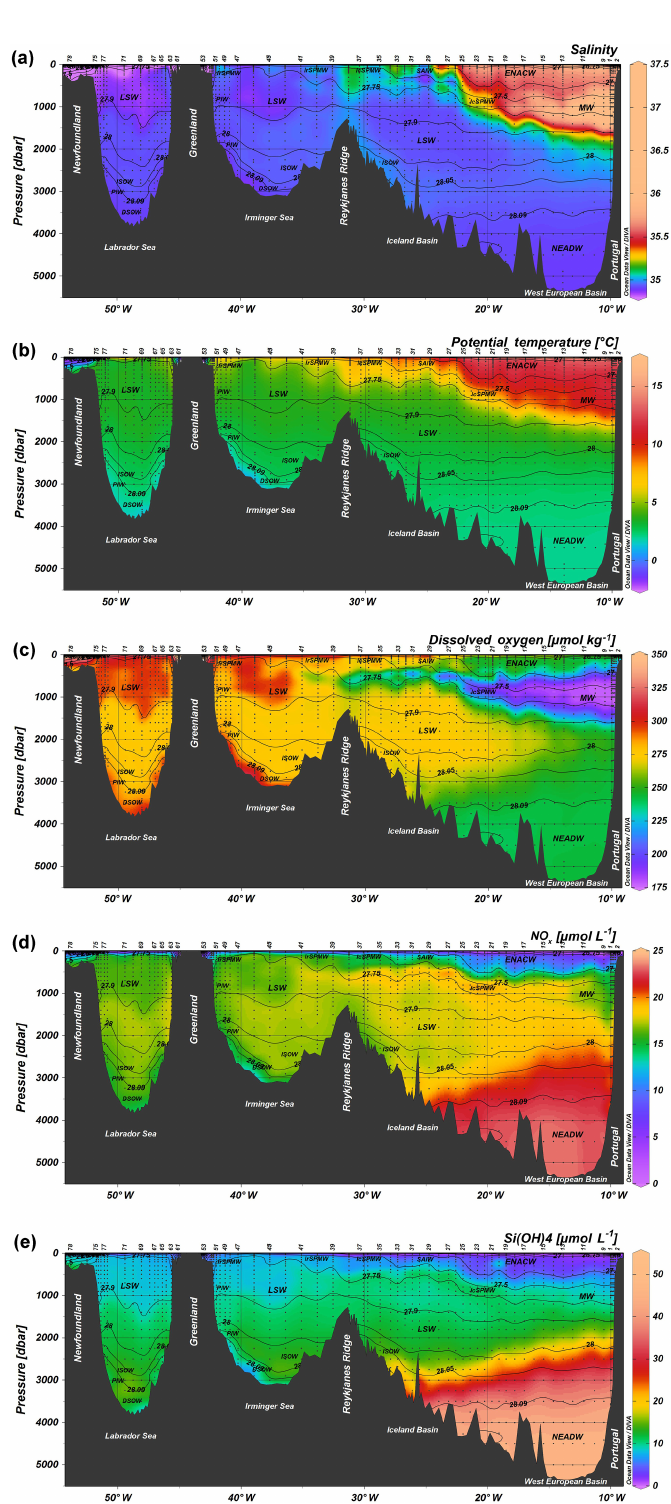
Figure 2. Section plots for (a) salinity, (b) potential temperature ( ◦ C), (c) dissolved oxygen (µmolkg − 1 ), (d) nitrate + nitrite (µmolL − 1 ), and (e) silicic acid (µmolL − 1 ) during the GEOVIDE cruise. Water masses are indicated in black, MW: Mediterranean Water; ENACW: North Atlantic Central Water; NEADW: North East Atlantic Deep Water; LSW: Labrador Sea Water; ISOW: Iceland–Scotland Overflow Water; SAIW: Subarctic Intermediate Water; IcSPMW: Iceland Subpolar Mode Water; IrSPMW: Irminger Subpolar Mode Water. Station locations are indicated by the numbers at the top of the panel. These plots were generated by Ocean Data View (Schlitzer,